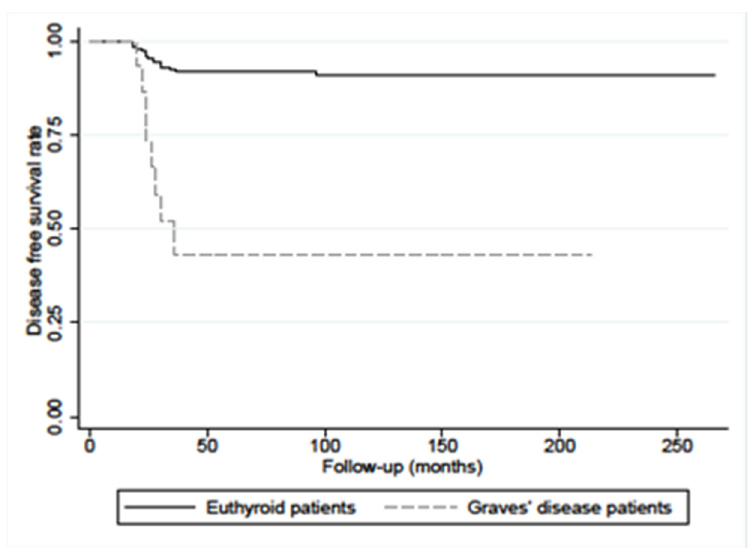
Figure 5. Disease-free survival (DFS) in PC/GD patients (n.15) and in matched euthyroid PC control patients (n.148) with carcinoma >1 cm showed a statistical difference ( p < 0.0001 calculated with log-rank test).